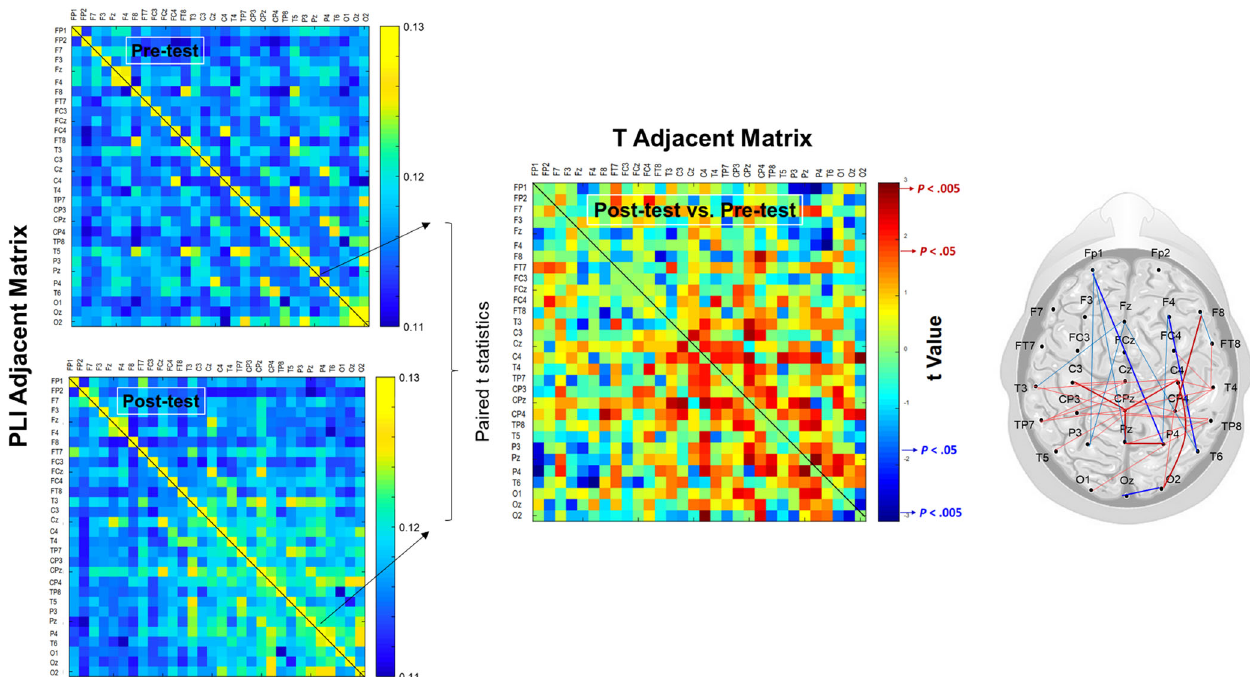
Fig. 6 Acquisition of the adjacent matrix of t -values that represent training effect on functional connectivity by contrasting the phase- lag index (PLI) of electrode pairs between the pre-test and post-test conditions with paired t statistics. Supra-threshold connectivity was denoted as a signi fi cant difference in PLI between the pre-test and post-test ( p <